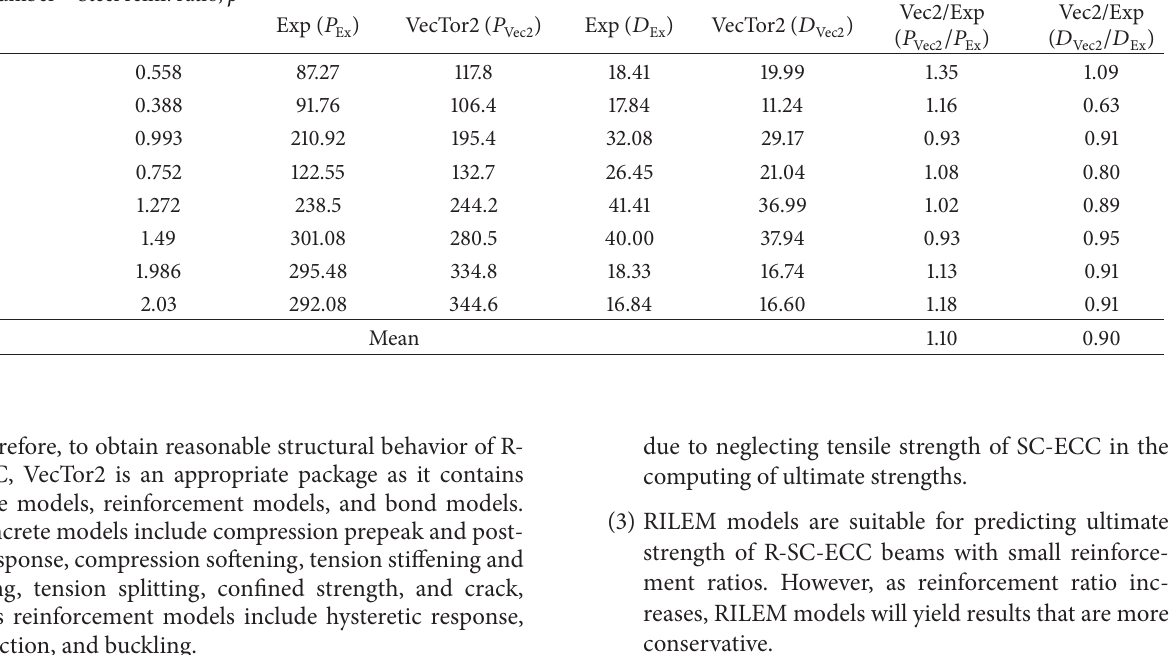
Table 9: Ultimate load deflection: VecTor2 and experimental results. Beam number Steel reinf. ratio,